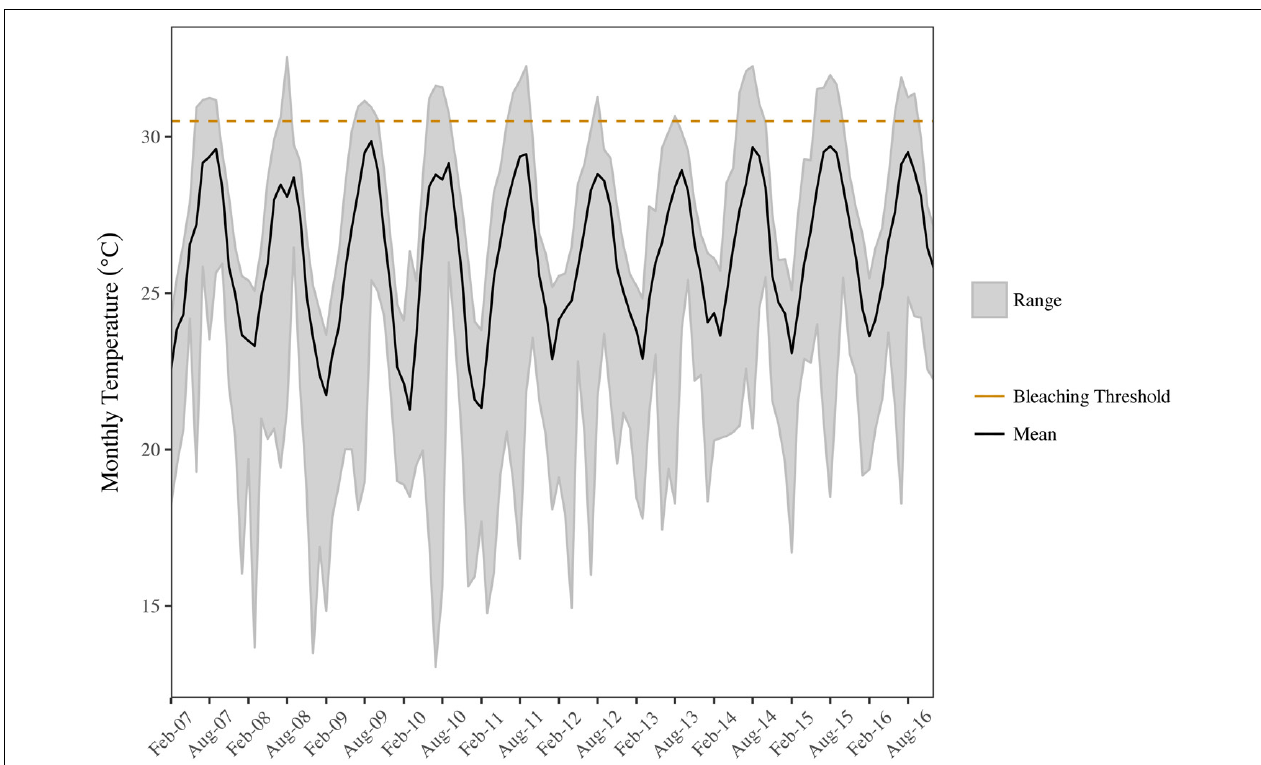
FIGURE 2 | Minimum, mean, and maximum monthly benthic temperatures for the SECREMP region. The black line indicates the mean monthly temperature, the gray ribbon is the range between the monthly minimum and maximum, and the dashed orange line indicates a documented bleaching threshold for the Florida Reef Tract (30.5 ◦ C; Manzello et al., 2007).